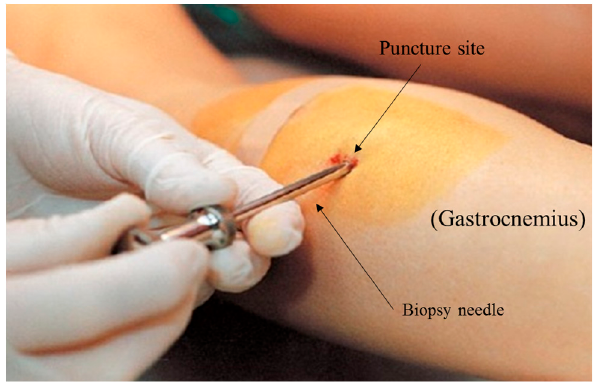
Figure 4. Illustration of an invasive muscle biopsy being performed on the gastrocnemius muscle.